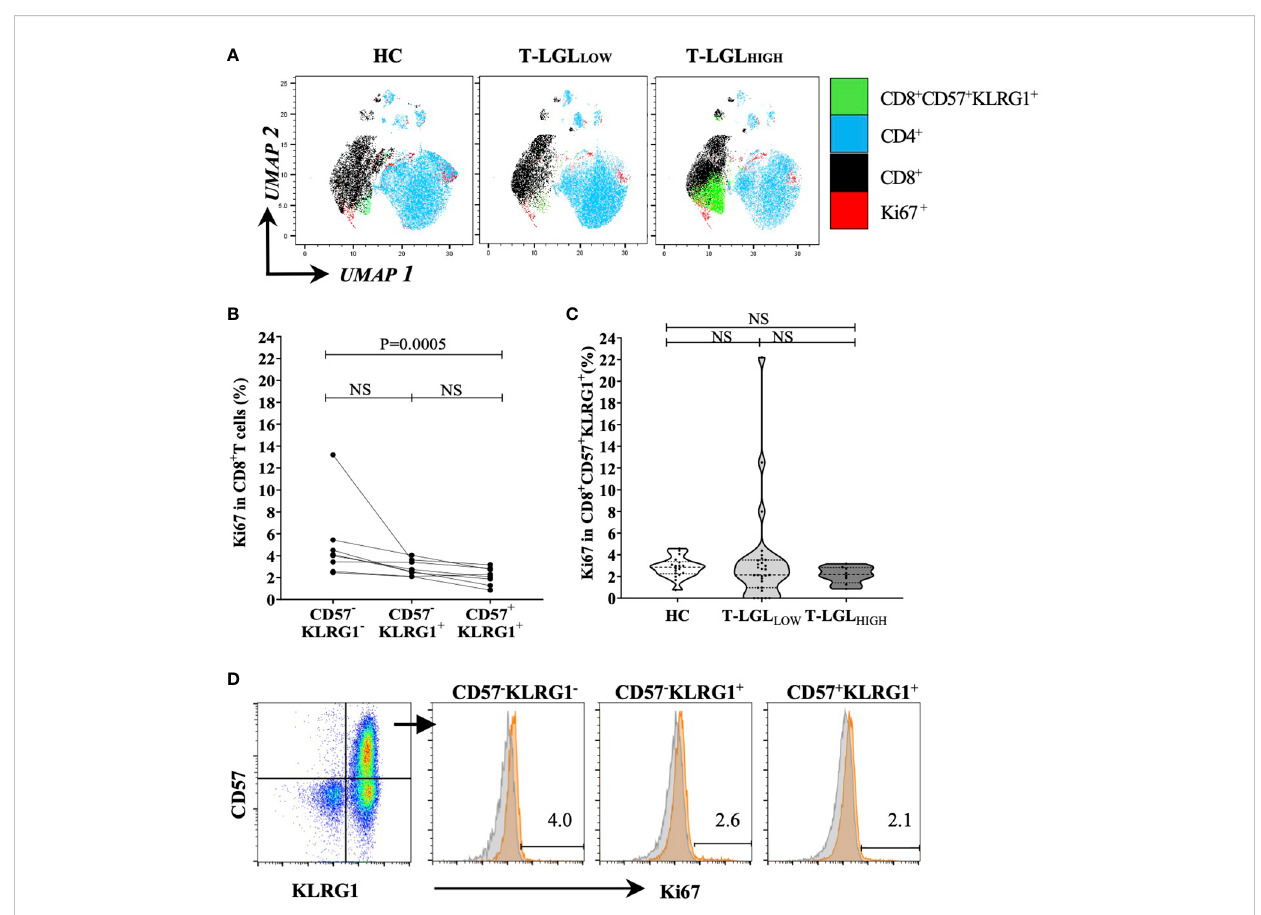
FIGURE 4 Proportion of Ki67 between HC and IBM. (A) UMAP analysis. we selected a total of 20,000 T cells per donor group (HC n=19, T-LGLNEG n=31, T- LGLHIGH n=8), and concatenated into a single matrix. T cells were identi fi ed based on the number of cells expressing phenotypical markers CD4, CD8, CD57, KLRG1 and Ki67. (B) Percentage of Ki67-expressing CD8+ T cells in the CD57-/+, KLRG1-/+ subsets in IBM T-LGLHIGH patients (n=8). (C) Percentage of CD8+ CD57+KLRG1+ T cells expressing Ki67 in the HC and IBM T-LGLLOW and T-LGLHIGH donor groups. Statistical analysis was performed using Friedman test with Dunn ’ s post-hoc test for multiple comparisons. The P-values are indicated; NS= Not Signi fi cant. (D) Representative fl ow cytometry biplot and histograms showing the median frequency of Ki67 in the three CD57-/+, KLRG1-/+